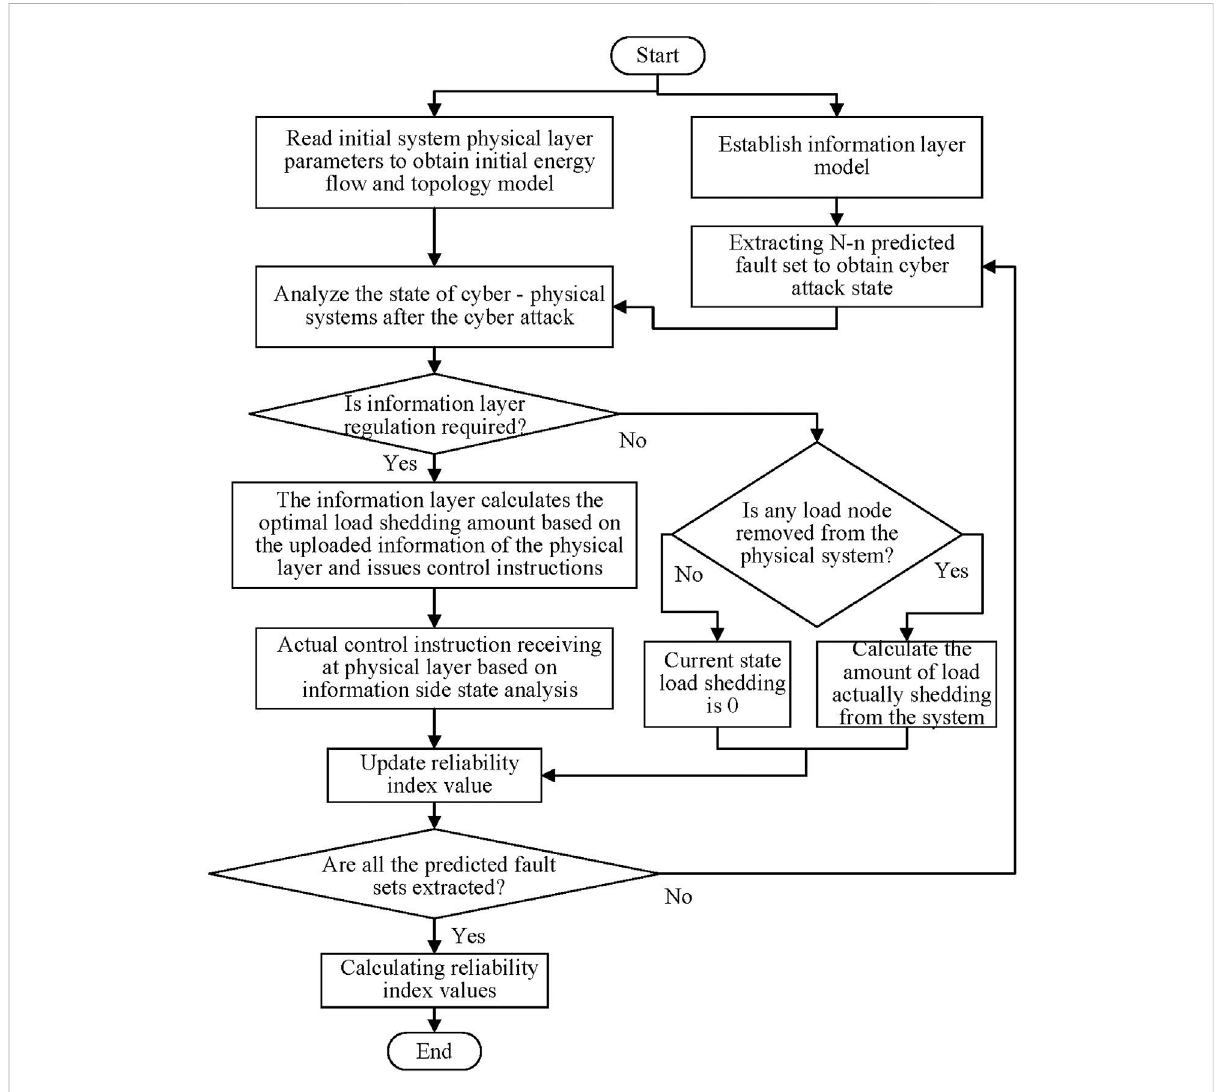
FIGURE 5 Reliability assessment process of the